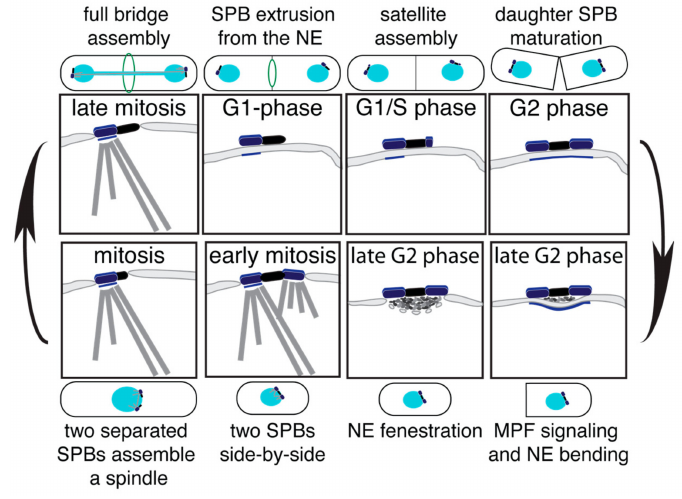
Figure 4. The duplication cycle of the SpSPB. The illustrations indicate the different stages of the SpSPB duplication process, and subsequent nuclear envelope (NE) insertion and ejection. The corresponding cell morphology is indicated